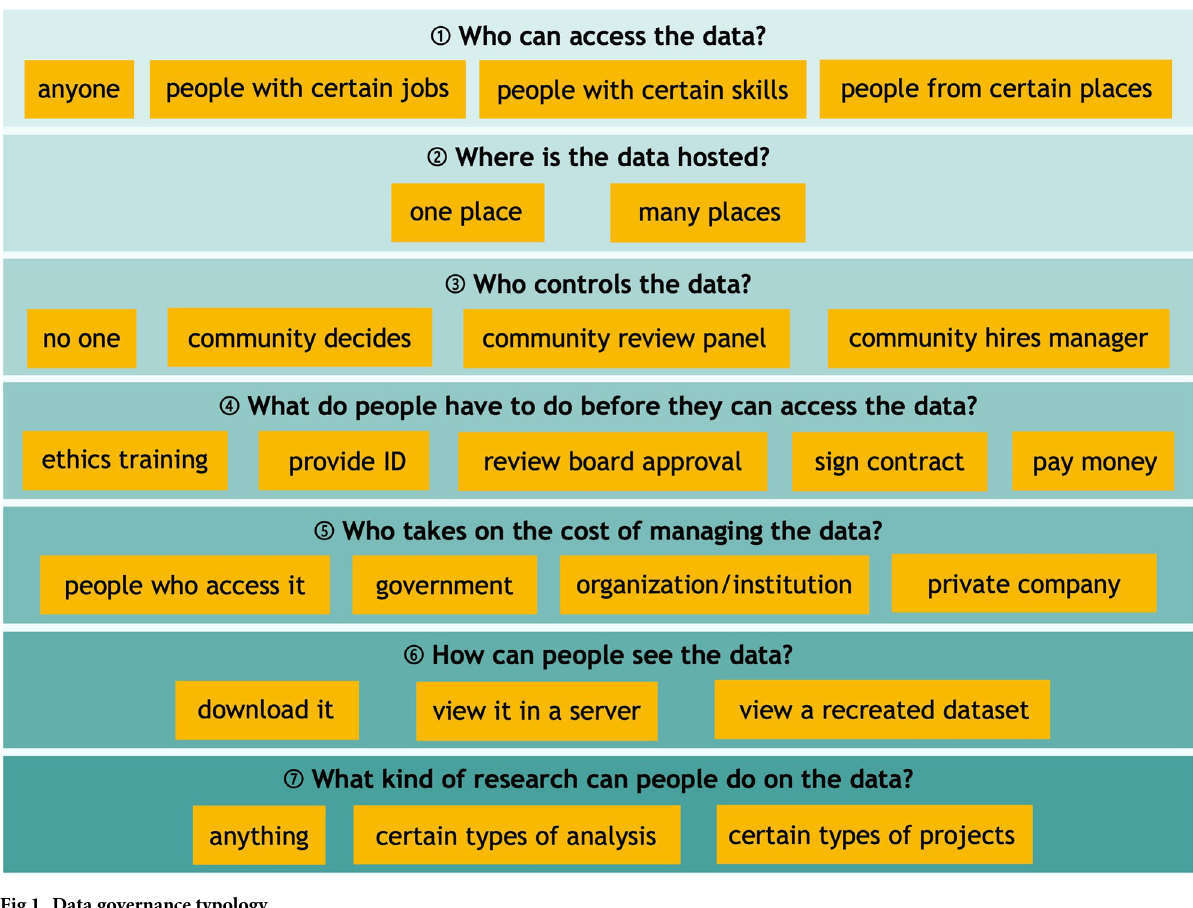
Fig 1. Data governance